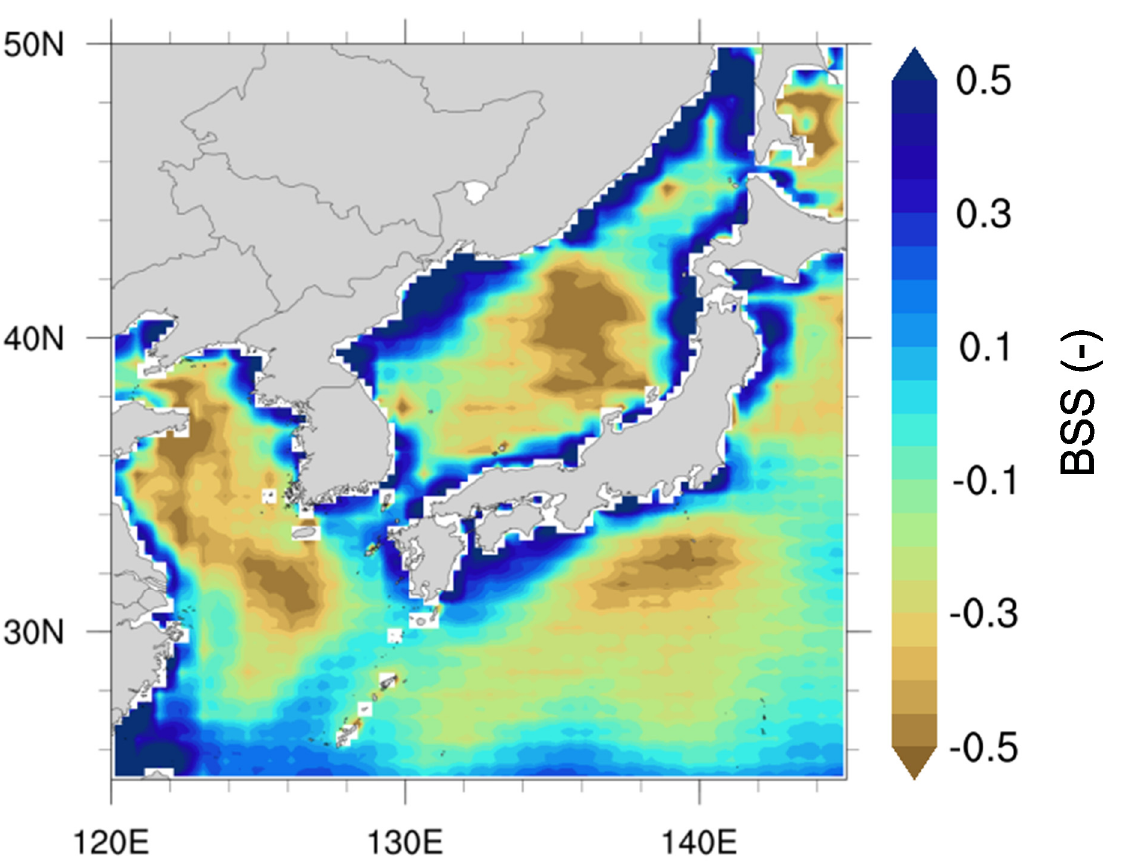
Figure 5. Modified Brier skill score (BSS) spatial distribution of wind speed error variance comparing hindcast estimates against ERA-Interim data, where DASCAT values were regarded as “True”.